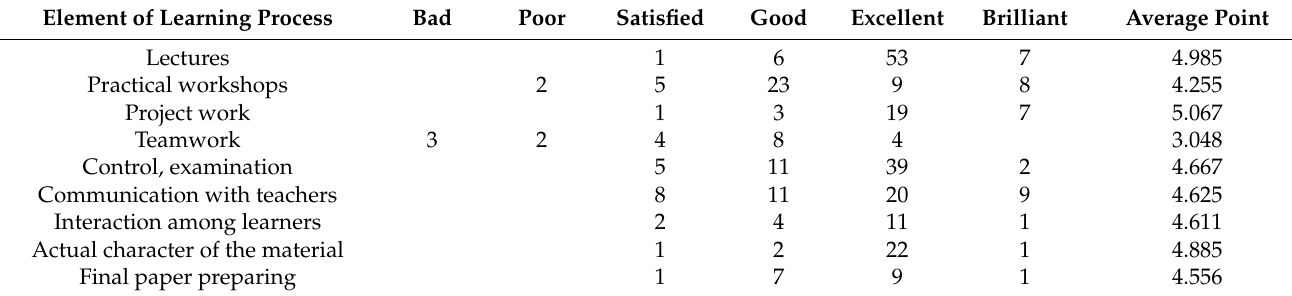
Table A4. Points awarded by students on the elements of the organization of the educational process in the framework of the traditional university pedagogy configuration, November 2020 (N4 = 67).